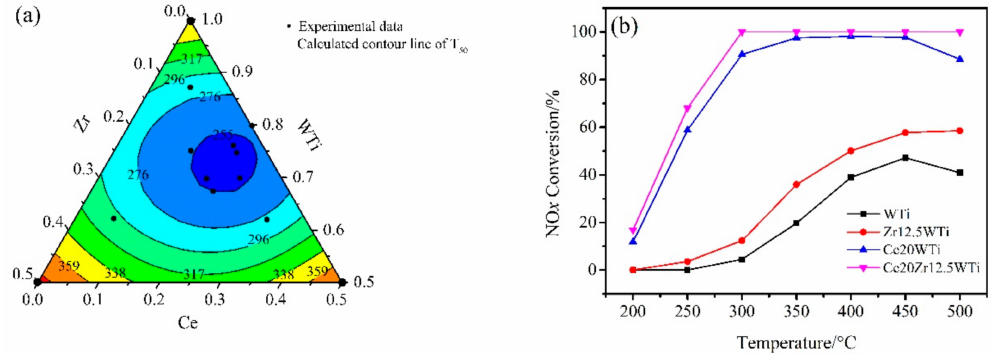
Figure 1. ( a ) T 50 contour lines of NO x and ( b ) NO x conversion of 200–500 ◦ C over Ce x Zr y WTi